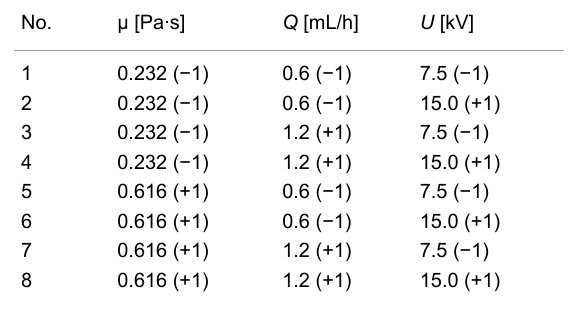
Table 5: Design matrix of a 2 3 factorial design.